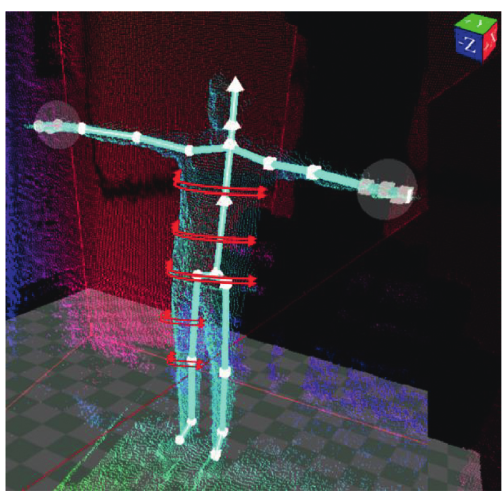
Figure 6: Complex 3D garment measurements: front perimeters at chest, waist, hip, thigh, knee, and wrist.